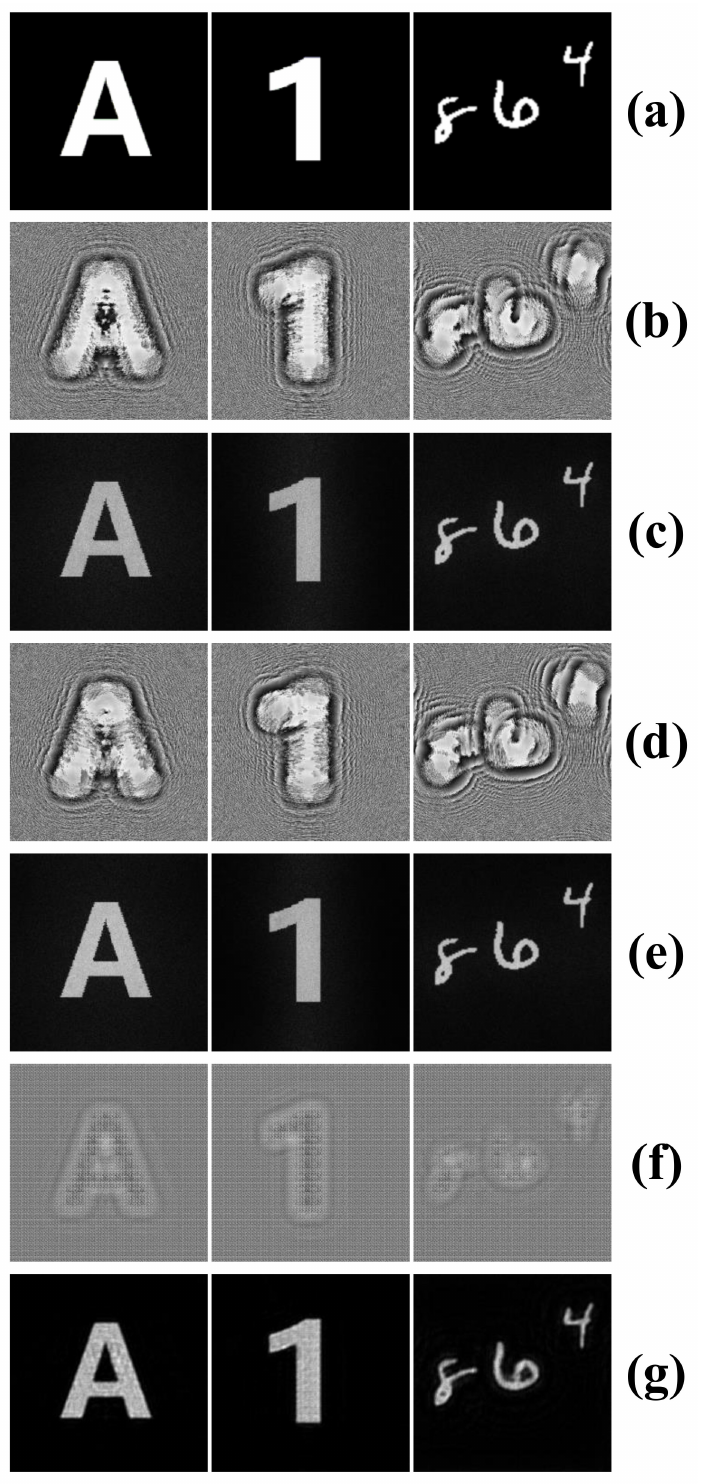
Figure 4. Hologram generation and reconstruction of planar images. Row ( a ) is the target image, row ( b ) is holograms generated by network, row ( c ) is the reconstruction result of network, row ( d ) is holograms generated by iterative ASM, row ( e ) is the reconstruction result of iterative ASM, row ( f ) is holograms generated by holo-encoder, and row ( g ) is the reconstruction result of